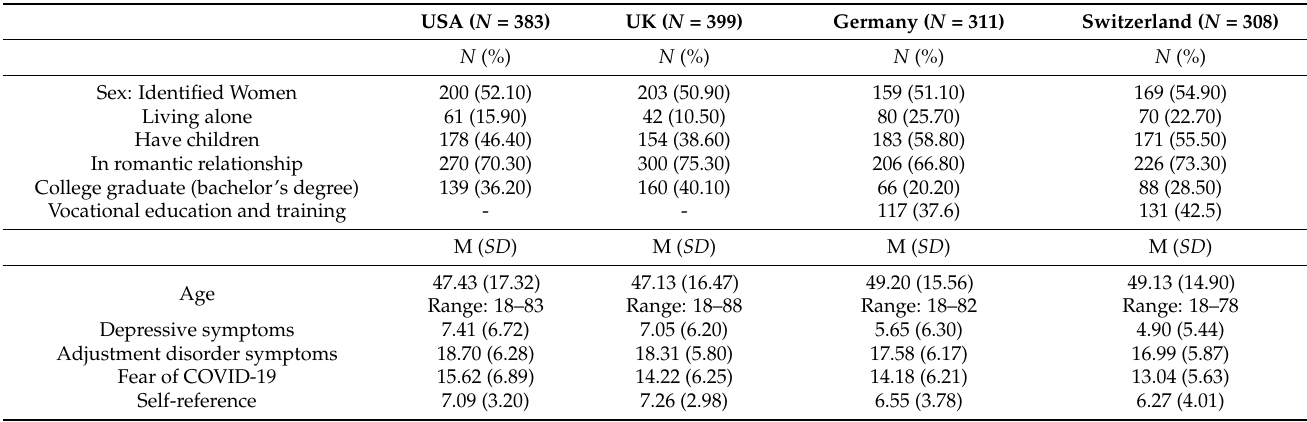
Table 1. Sociodemographic and Study